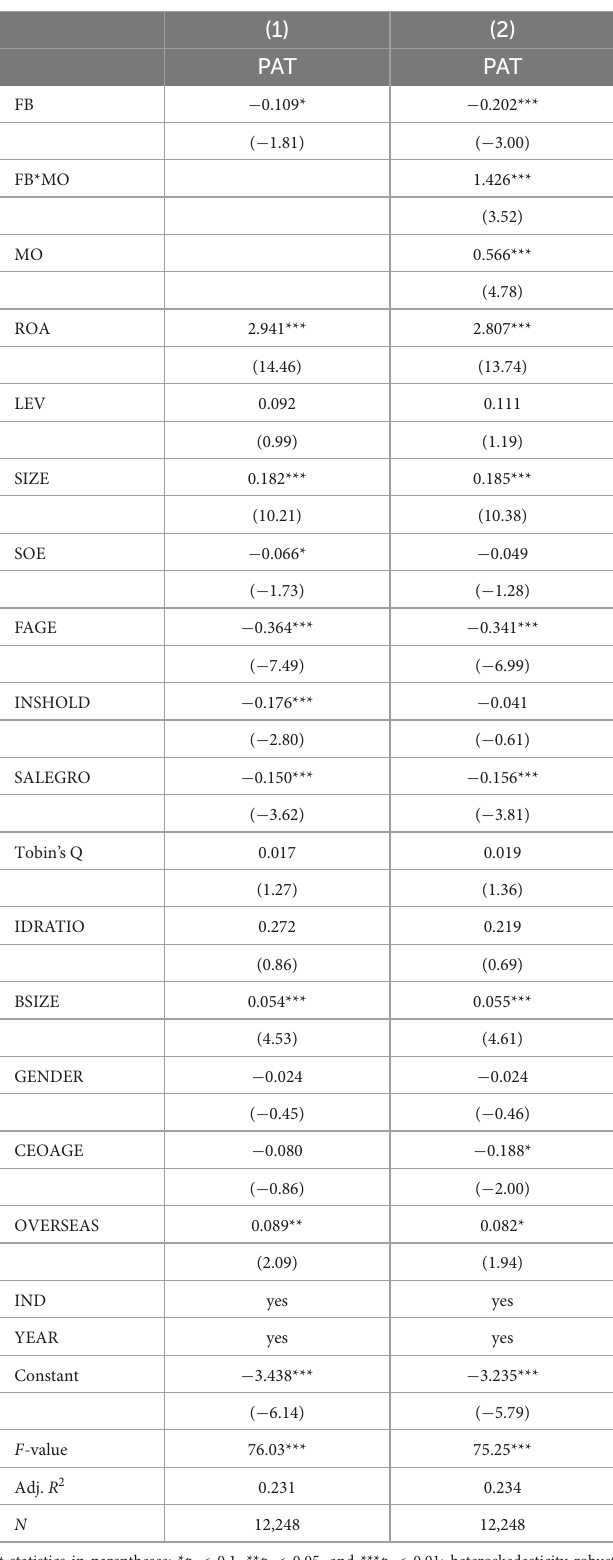
TABLE 6 Results of the robustness check using additional control